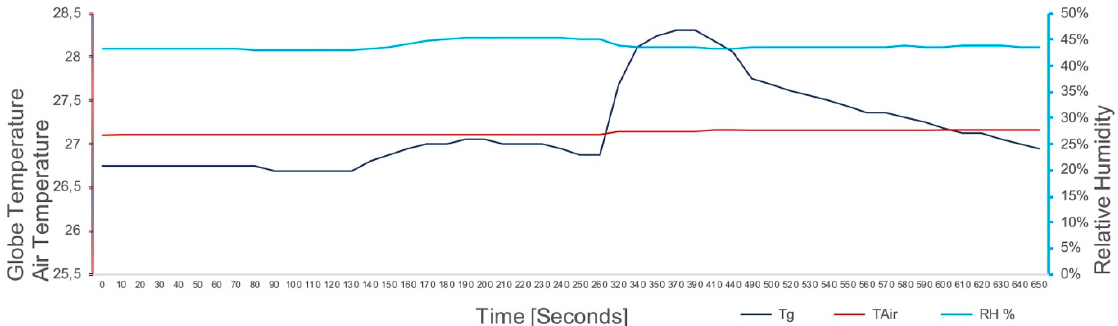
Figure 6. Globe temperature, air temperature, and relative humidity curves.